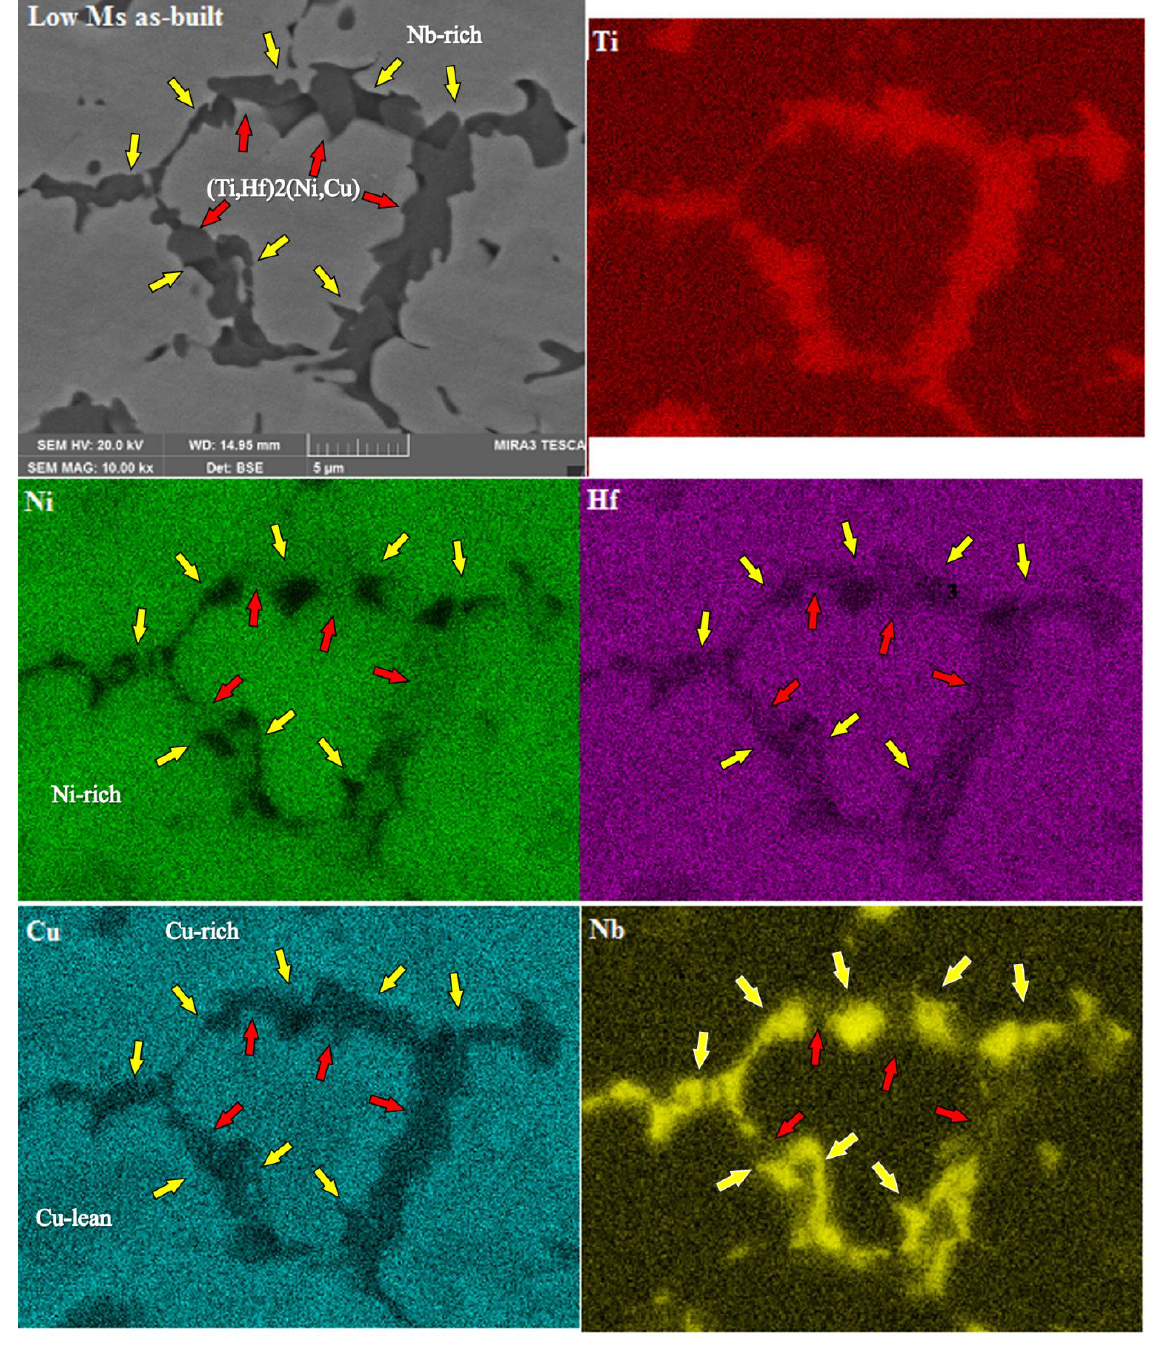
Figure 9. EDS mapping around the precipitates in Ti 43 Ni 33 Hf 10.5 Cu 11 Nb 2.5 low M s as-built sample shows high Nb content in the precipitates with the darkest contrast. The precipitates generally have higher Ti and Nb content.